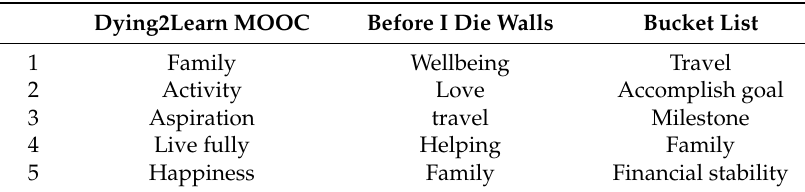
Table 2. Comparison of